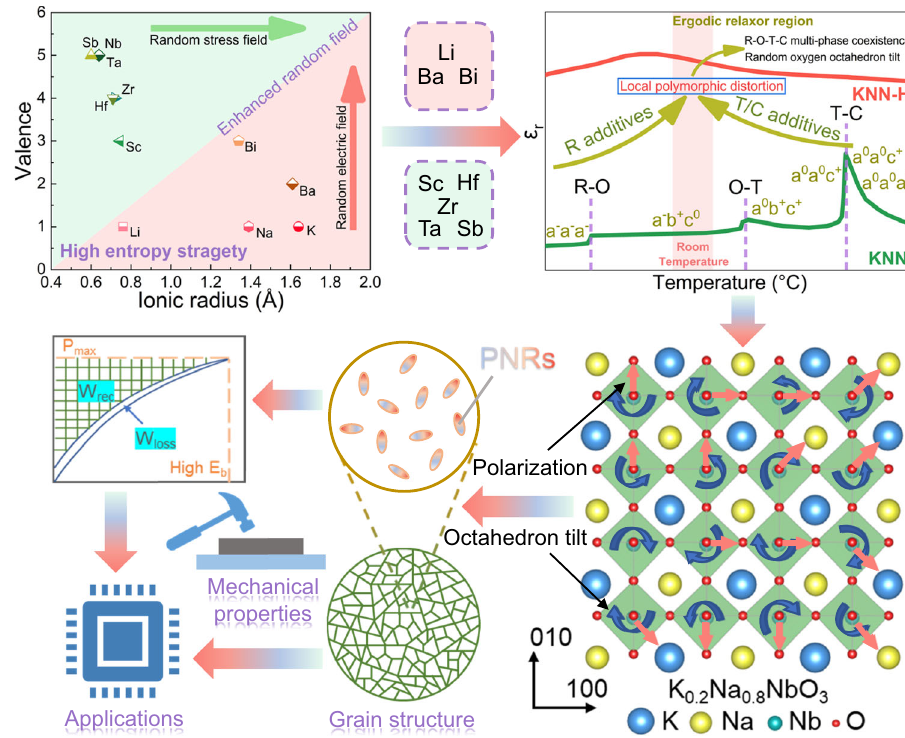
Fig. 1 Schematic diagram of high-entropy design strategy for local polymorphic distortion and giant energy storage